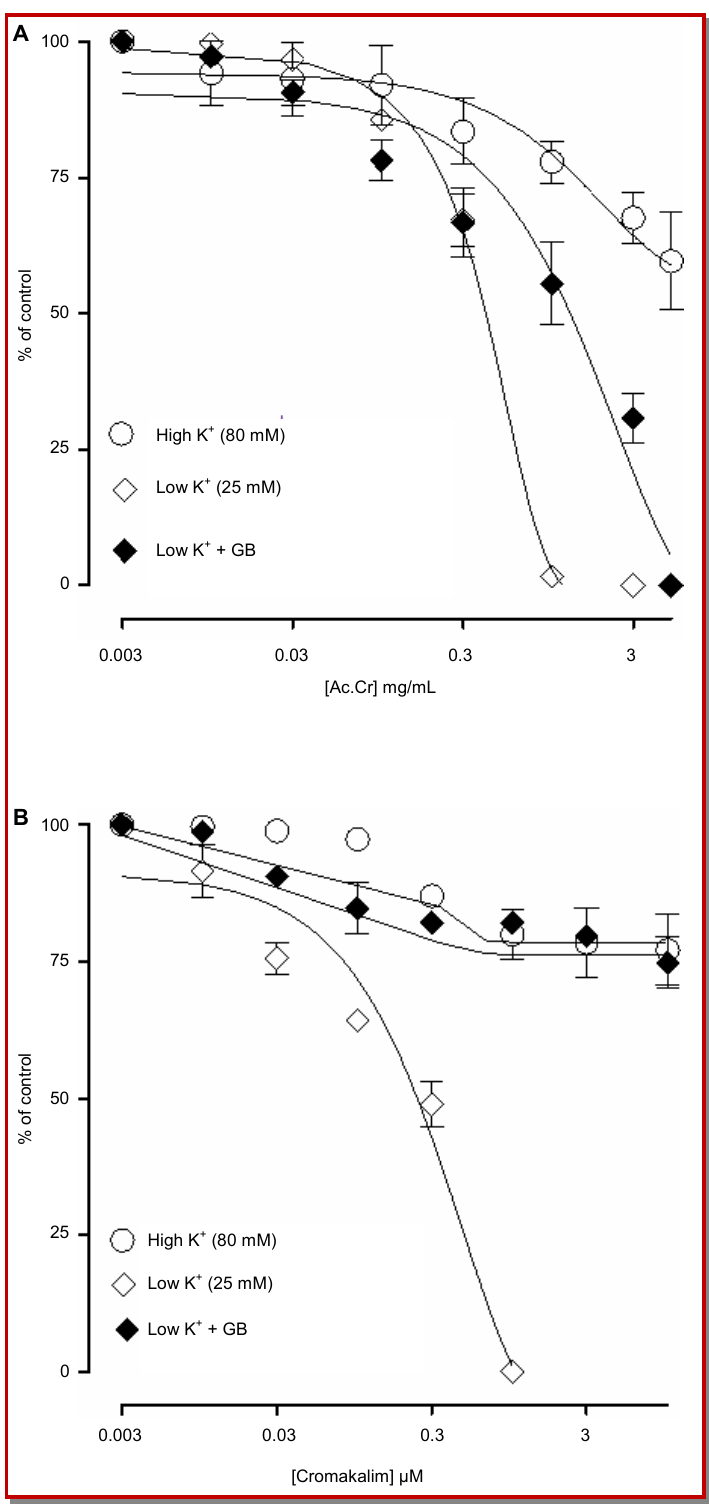
Figure 3. The concentration-dependent inhibitory effect of (A) the crude extract of A capillus-veneris (Ac.Cr) and (B) cromakalim against low K + (25 mM) in the absence and presence of glibenclamide (GB, 10 µM) and against high K + (80 mM)-induced con- tractions in isolated rabbit jejunum preparations. Values are expressed as mean - ± S.E.M; n =